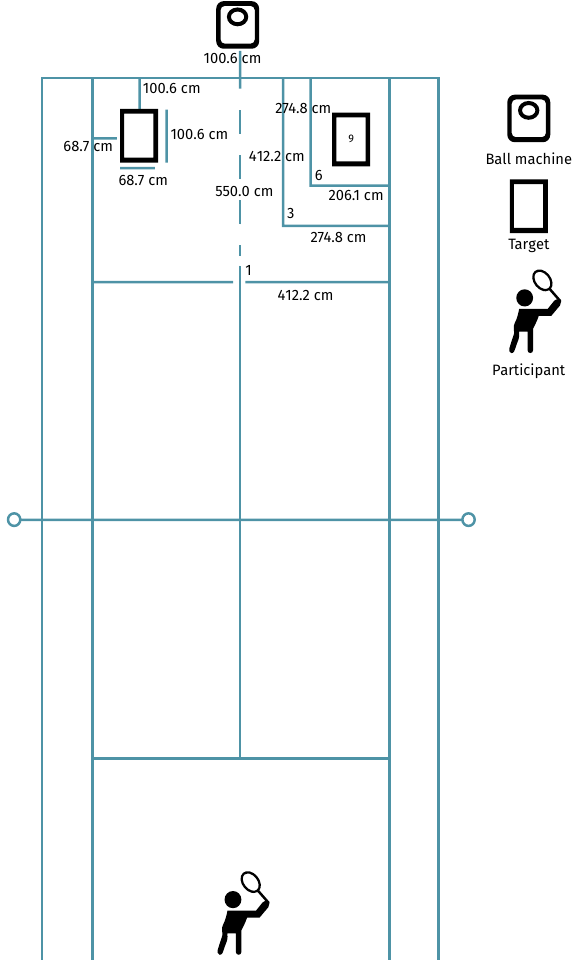
Figure 1. PTTF-test protocol set-up including the dimensions and location of the targets and the point awarding for stroke accuracy based on ball bounce